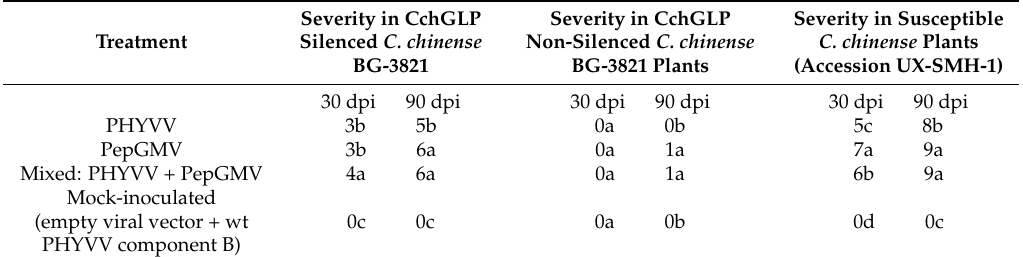
Table 1. Severity * of disease in silenced and non-silenced C. chinense BG-3821 plants.